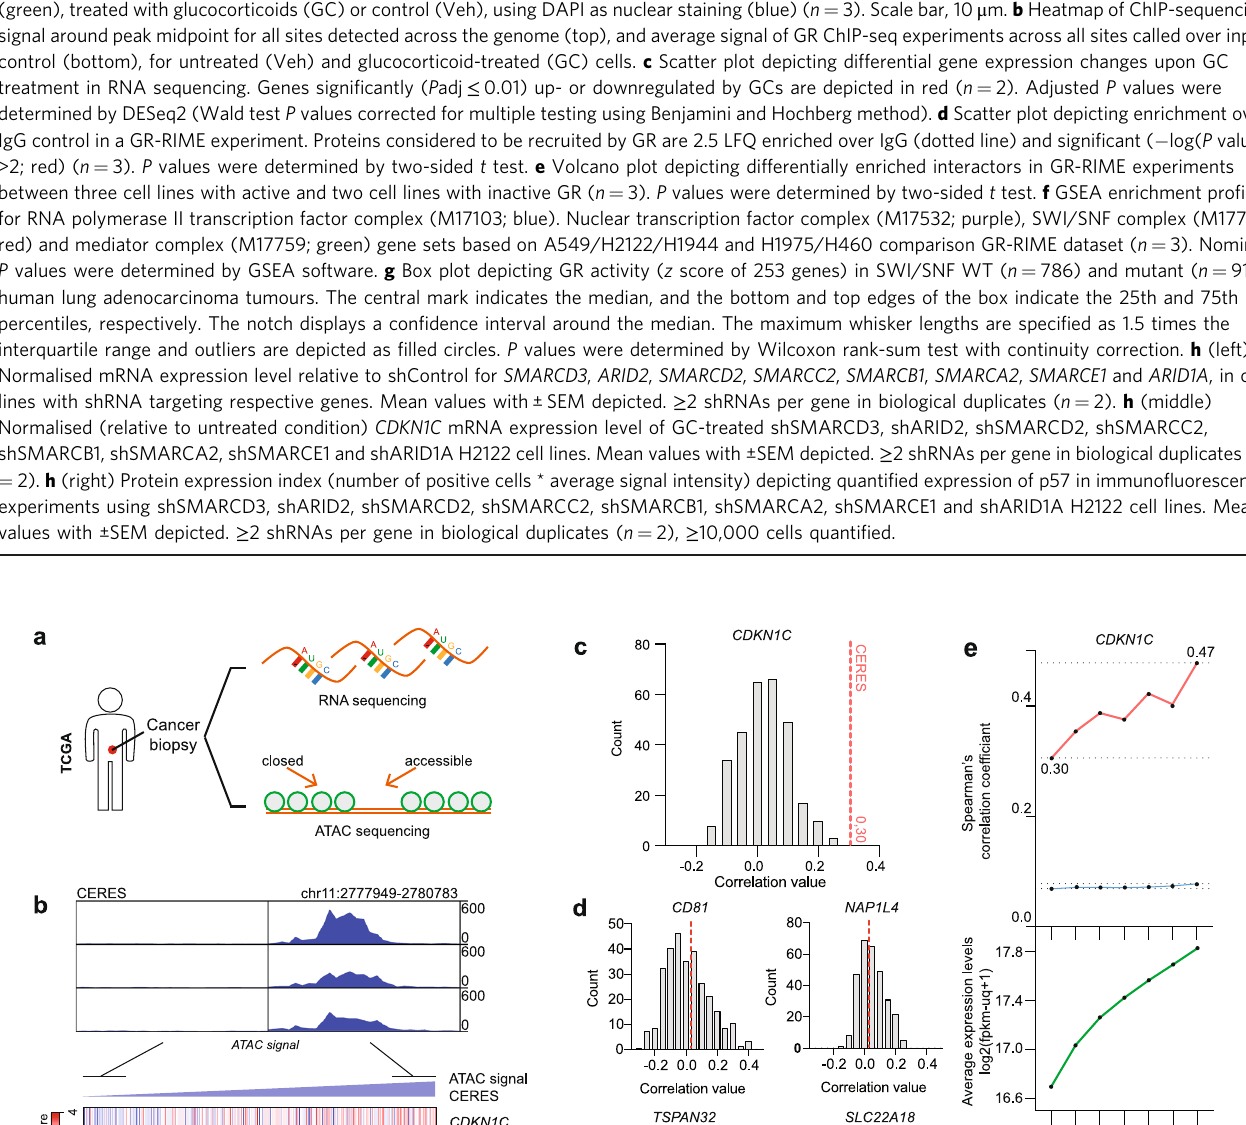
Fig. 6 CDKN1C mRNA expression is linked to chromatin accessibility of CERES and GR levels in clinical samples. a Biopsies of human primary non- lymphoid solid cancers were subjected to whole-transcriptome and chromatin accessibility analysis by the TCGA ( n = 404). b (top) Representative samples showing chromatin accessibility signal at CERES enhancer. b (bottom) Expression of CDKN1C , MKI67 , PCNA , and FOXM1 sorted based on CERES accessibility. Survival events (alive = white, dead = green), SWI/SNF mutation status (WT = white, mutated = green), and cancer types are displayed below. c Histogram depicting correlation value counts for CDKN1C expression levels and 306 up- and downstream enhancers in its genomic vicinity. Red line shows the correlation of CERES accessibility with CDKN1C expression. d Histograms showing correlation of four proximal genes with the accessibility of 306 up- and downstream enhancers surrounding CDKN1C . Red lines show correlations of these genes with CERES accessibility. e Line plot showing Spearman ’ s correlation of accessibility of CERES (red) or 306 (blue) surrounding enhancers with CDKN1C mRNA levels, and NR3C1 mRNA levels (green). In this study, we describe a GR-driven distal enhancer (>100 kb numerous homeostatic cues and the circadian rhythm in various upstream of CDKN1C , within an intron of KCNQ1 gene) of which tissue types 84 . Prior research has suggested that CDKN1C is regulated in a complex combinatorial fashion, through an imprinting control the physical interaction with the CDKN1C promoter is enhanced by region and unidenti fi ed enhancers located in the KCNQ1 gene 33,34 . GR activation. Importantly, we functionally probed this enhancer NATURE COMMUNICATIONS| (2021) 12:4360